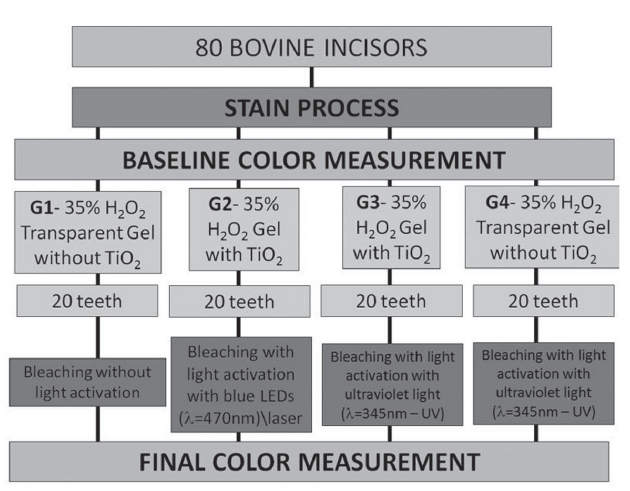
Fig. 2 – Experimental Design.